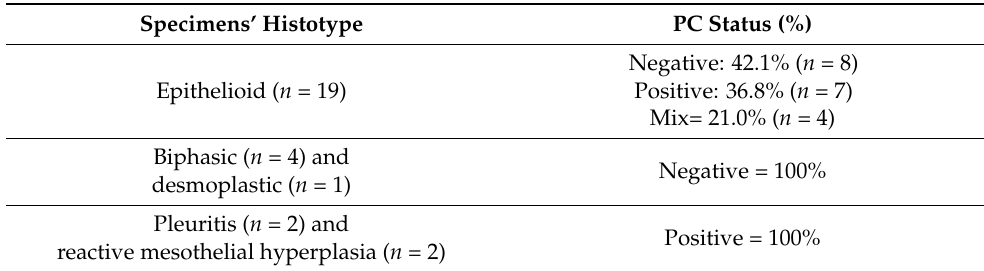
Figure 1. Primary cilium expression in Malignant Pleural Mesothelioma FFPE. ( A ) Representative images of PC positivity from two different epithelioid MPM. ( B ) Representative images of two different PC-negative tissues; upper panel, a biphasic MPM; lower panel, epithelioid MPM. ( C , D ) Representative images of PC intra-heterogeneity from two different epithelioid MPM. From left to right: A and B, haematoxylin and eosin staining (magnification 5×), arl13b immunostaining (magnification 5× and 20×); ( C , D ), haematoxylin and eosin staining (magnification 5×), arl13b immunostaining (magnification 5× and 40×). Ciliated cells are indicated with arrows. All the non-neoplastic cases retain PC. The results are summarized in Table 1. Table 1. PC expression in FFPE specimens. ( n ) = number of patients; mix = intra-heterogeneity in PC